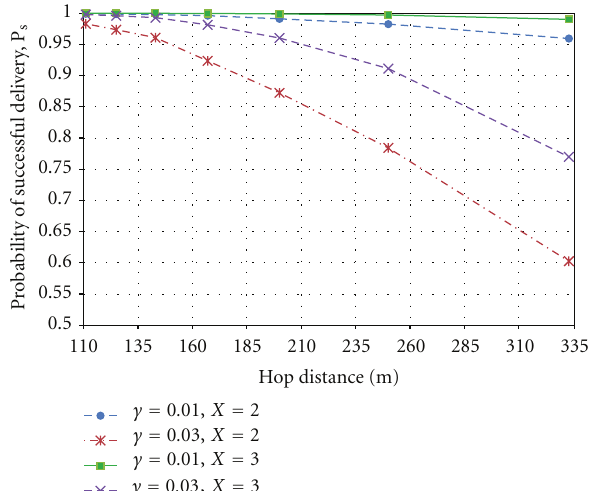
Figure 3: Probability of successful delivery versus hop distance.